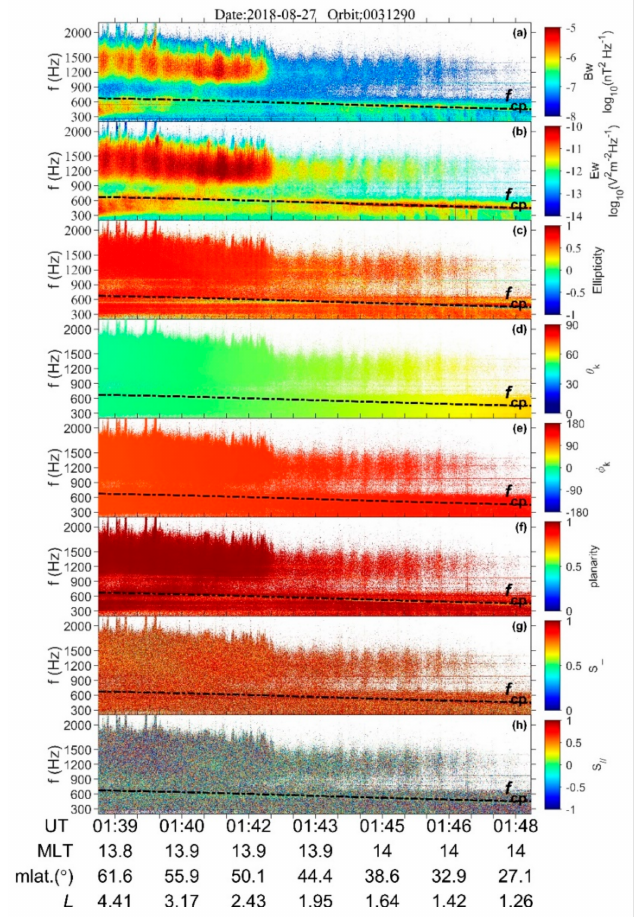
Figure 12. The wave propagation parameters computed by the singular value decomposition (SVD) method for the ELF/VLF waves in the high-latitude ionosphere during the geomagnetic storm recorded by orbit No. 0031290 on 27 August 2018. From top to bottom: the sum of the PSD values of the three components of the magnetic field ( a ) and the electric field ( b ); the ellipticity ( c ); the wave normal angle ( d ) and the azimuthal angle ( e ) for wave vector k; and the planarity ( f ) and the perpendicular and parallel component of the Poynting vector ( S ⊥ , S || ) ( g , h